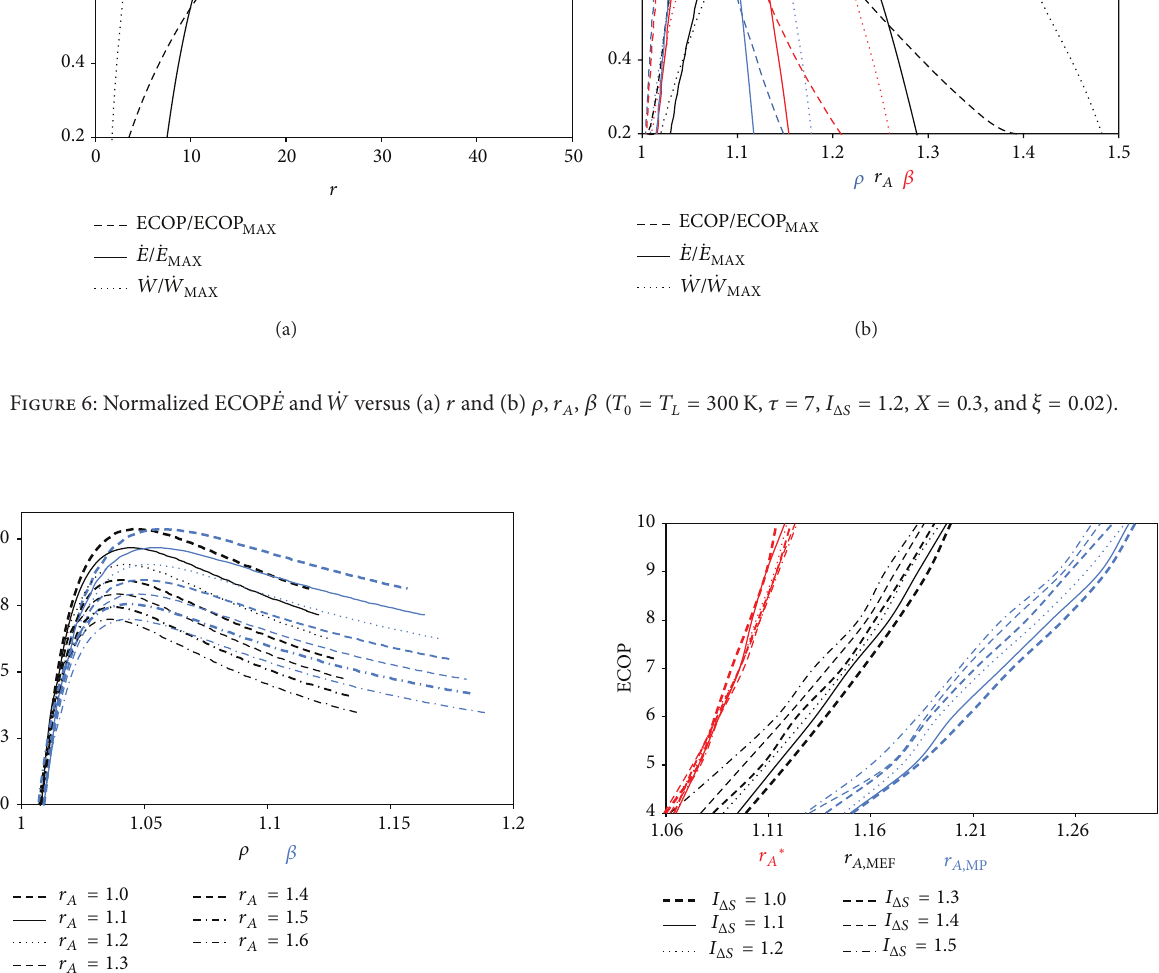
Figure 7: ECOP versus 𝜌 , 𝛽 for different Atkinson cycle ratios ( 𝐼 Δ𝑆 = 1.2, 𝛼 = 17 ) ( 𝑇